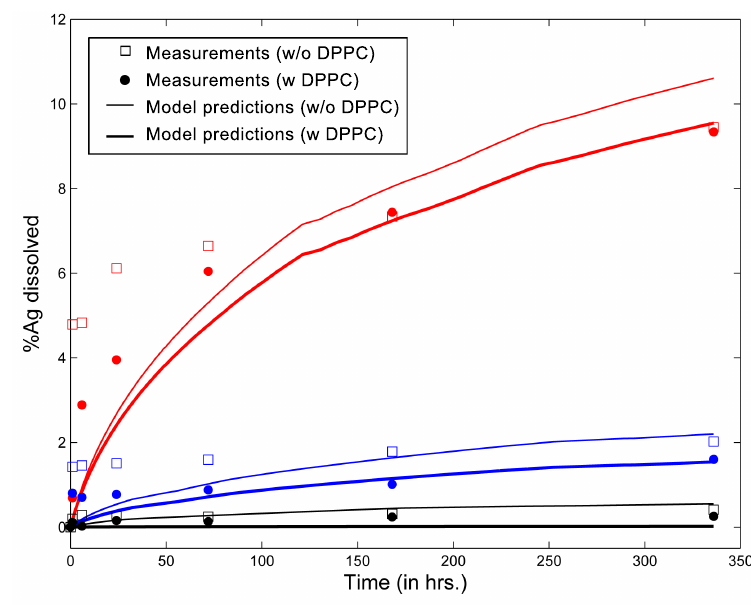
Figure 3. Comparison of model predictions of percent Ag dissolved in solution with in vitro measurements from Leo et al. [26] for citrate-coated silver ENMs (L20; initial mean diameter = 20 nm; other ENM properties in Table 5) incubated with and without DPPC for up to 14 days (results for pH 3 in red, for pH 5 in blue and for pH 7 in black).